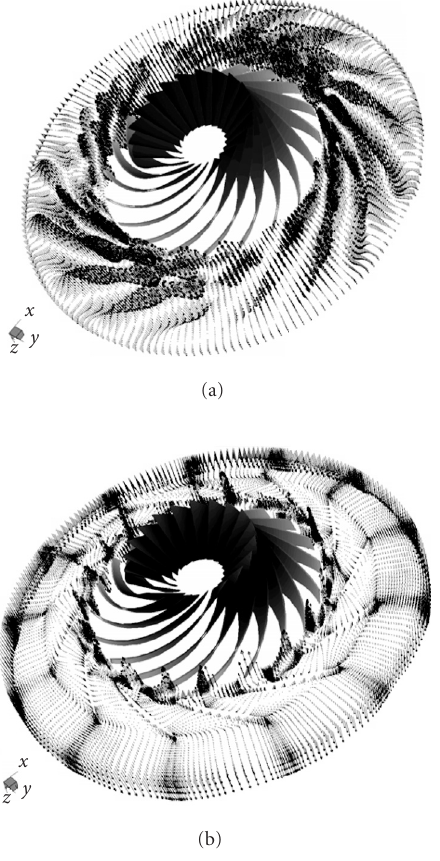
Figure 8: z -component of velocity on the di ff user center plane for the compressor with the (a) vaneless and (b) vaned di ff users.